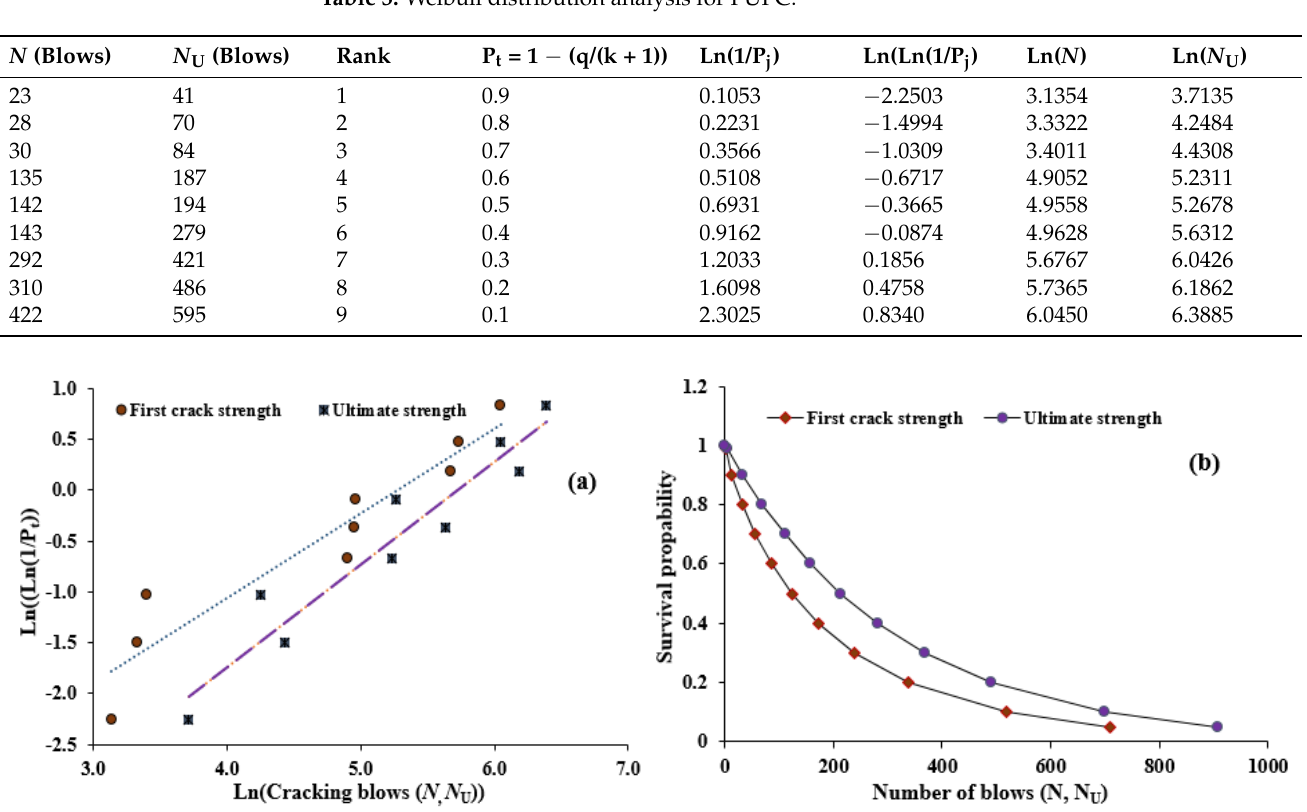
Table 3. Weibull distribution analysis for PUPC.